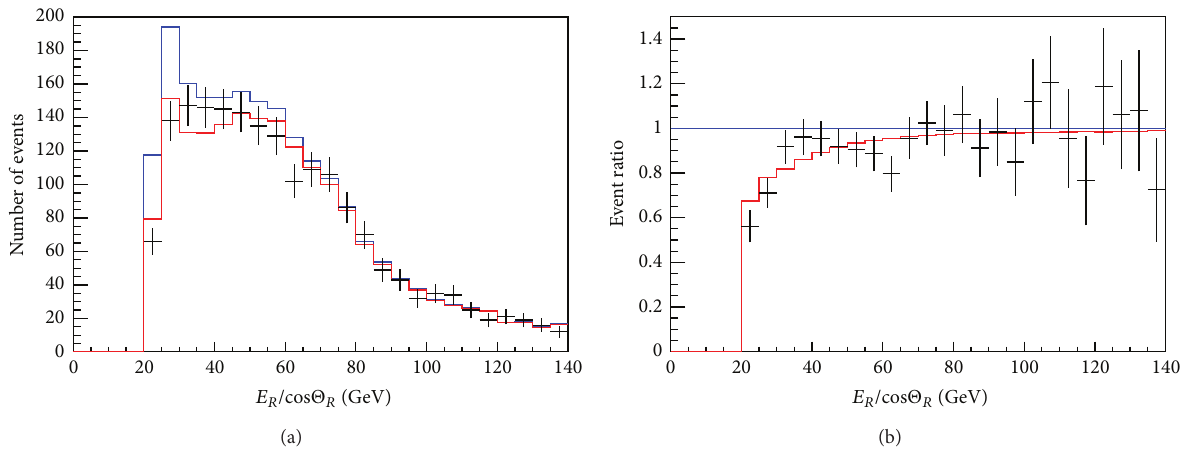
Figure 1: (a) Distribution of 𝐸 𝑅 / cos Θ 𝑅 for selected events. Black crosses are data with statistical uncertainties, whereas the blue histogram shows simulations of atmospheric neutrinos without neutrino oscillations plus the residual background from atmospheric muons. The red histogram shows the result of the fit. (b) The fraction of events with respect to the nonoscillation hypothesis as function of 𝐸 𝑅 / cos Θ 𝑅 . Same color code as for the left figure (figure from [22]).